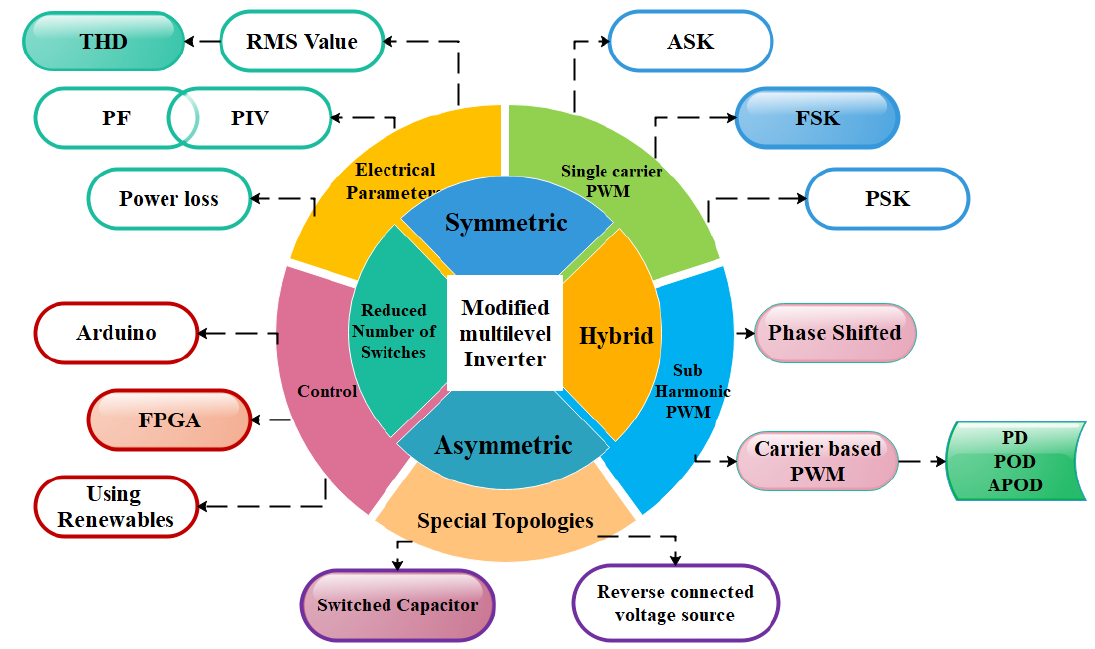
Figure 2. Classification of MLI types and techniques.